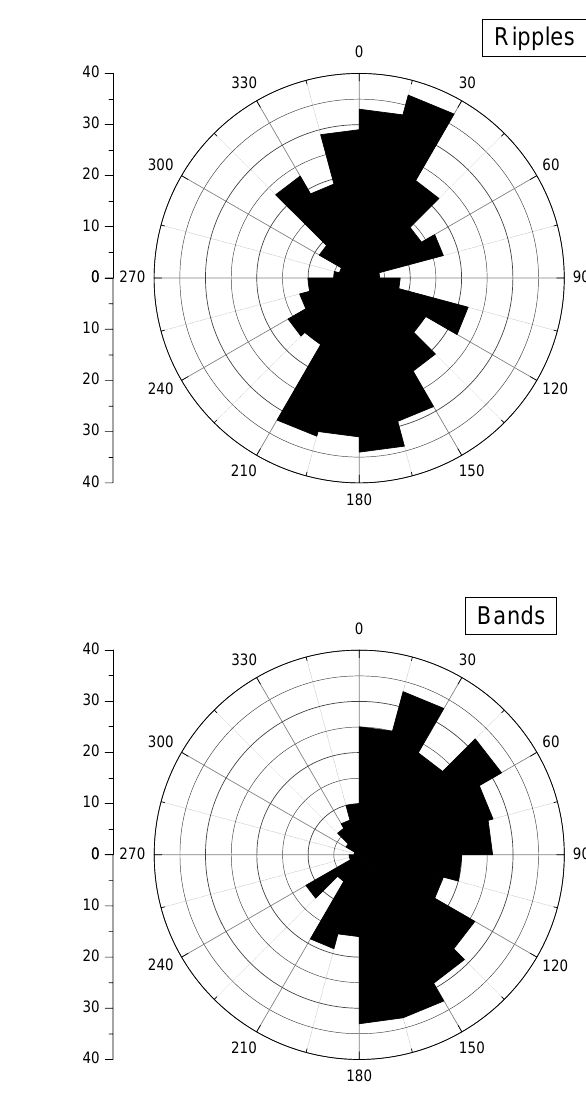
Fig. 6. Polar histogram of the propagation direction for bands and Fig. 6 - Polar histogram of the propagation direction for bands and ripples binned in 15 ° ripples binned in 15 ◦ intervals.